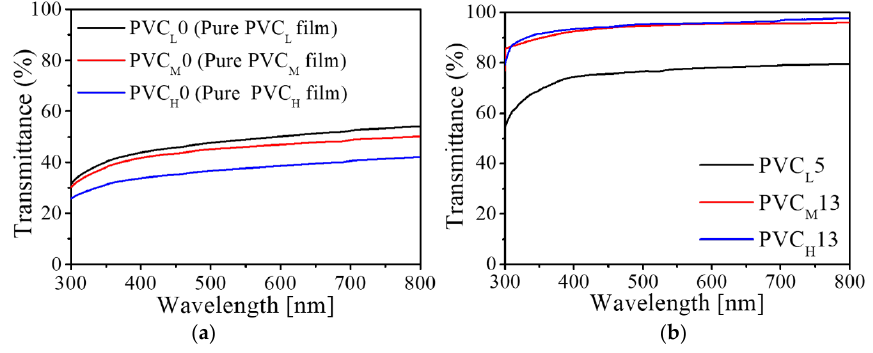
Figure 3. Optical property of the PVC films and gels: ( a ) Transmittance of the PVC films and ( b ) transmittance of the PVC gels.